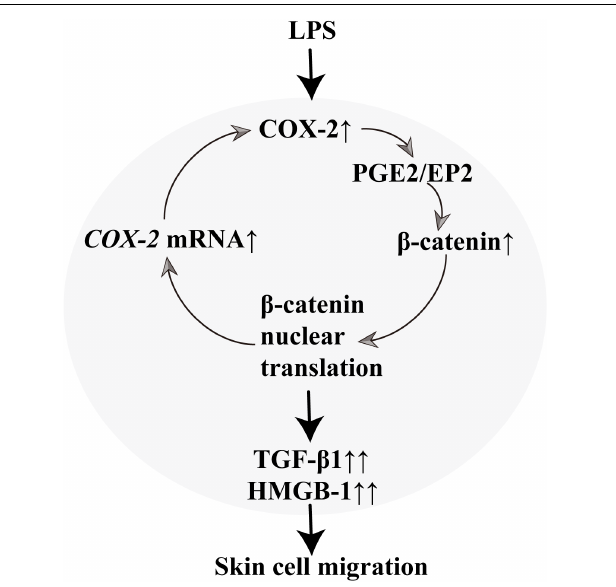
FIGURE 10 | The scheme of the β -catenin and COX-2